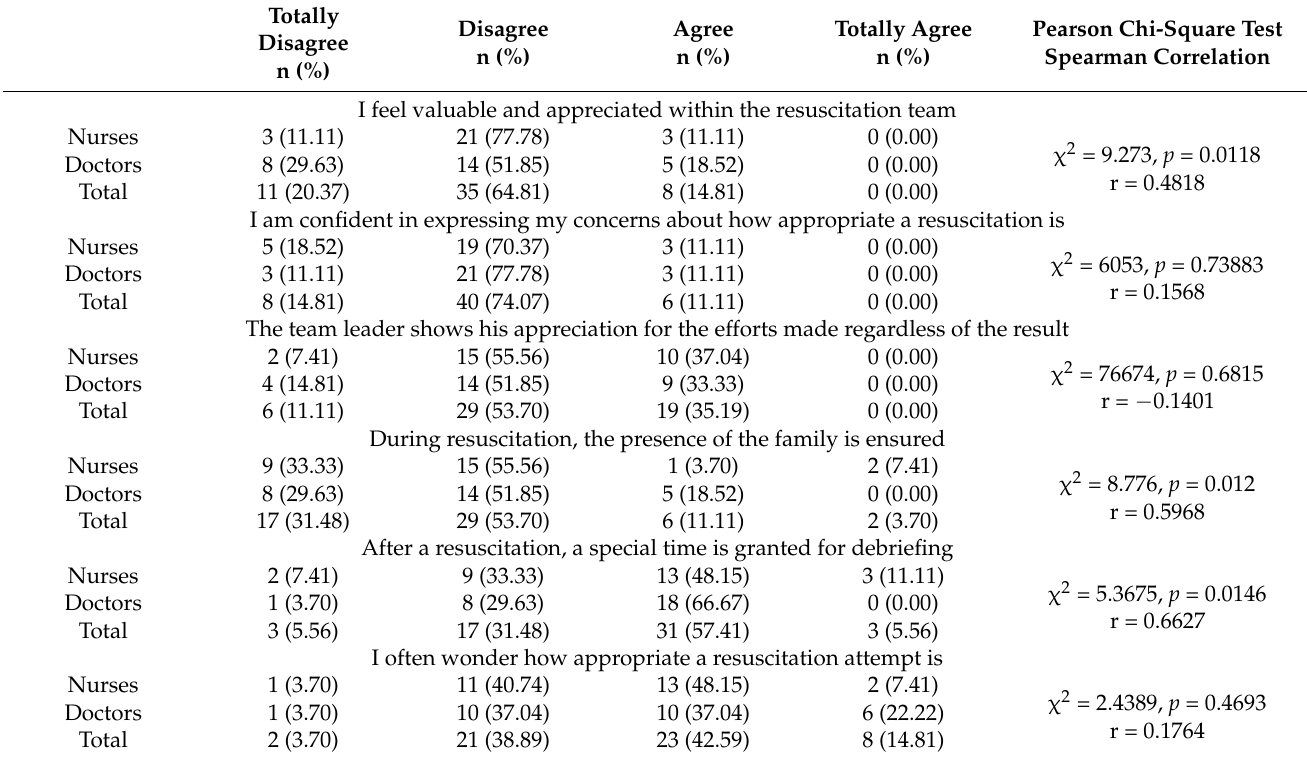
Table 2. Team performance during resuscitation.